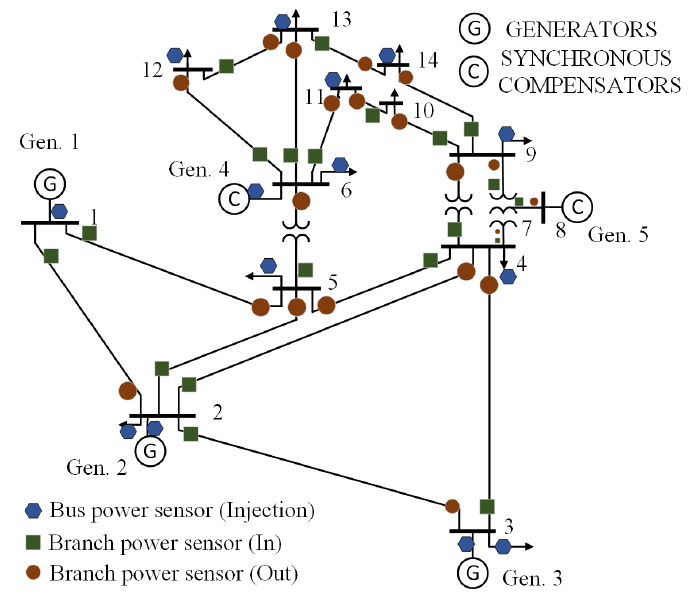
Figure 3. The IEEE 14-Bus system with sensors in different locations